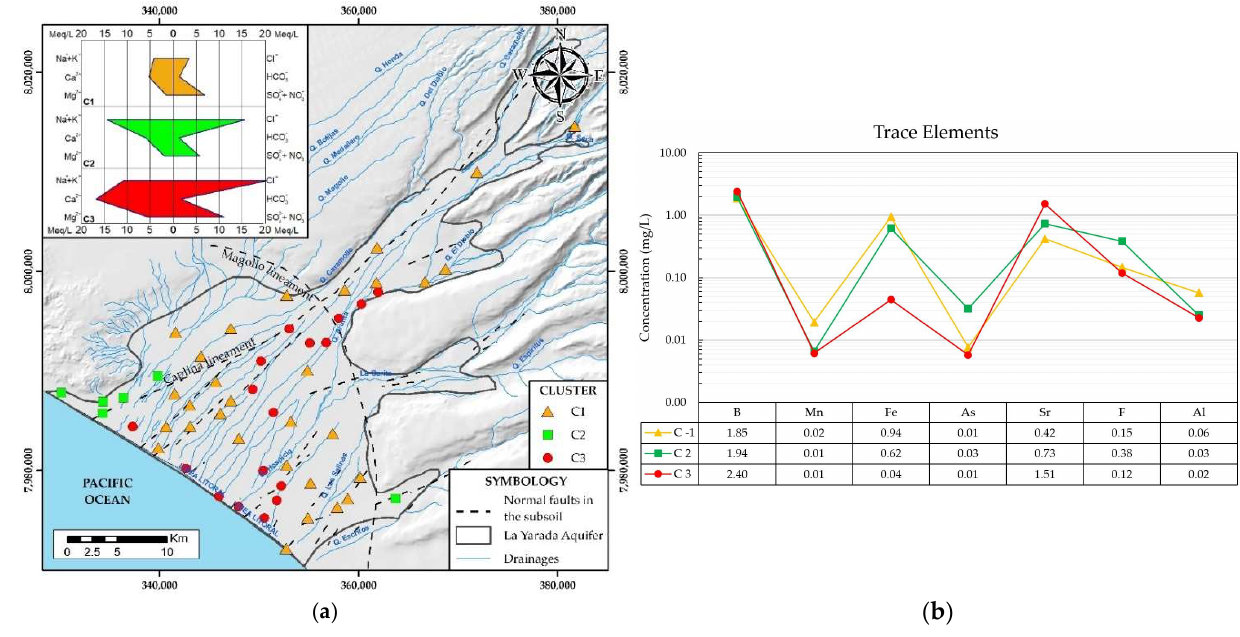
Figure 7. ( a ) Spatial distribution of the clusters. ( b ) Comparative diagram of trace elements between clusters.